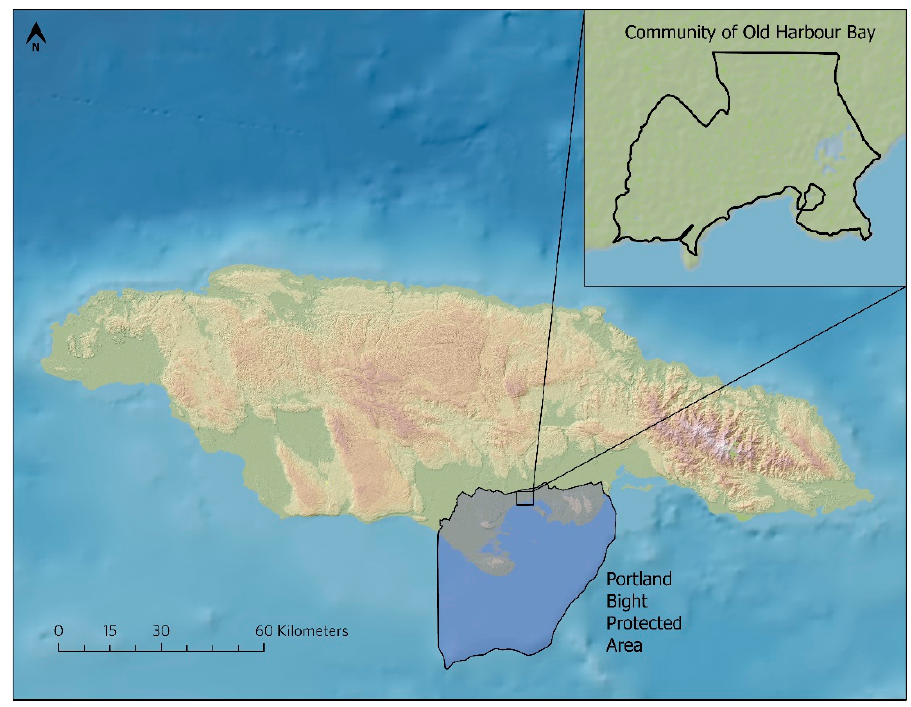
Figure 1. Reference map showing the location of the community of Old Harbour Bay, Jamaica within the Portland Bight Protected Area.